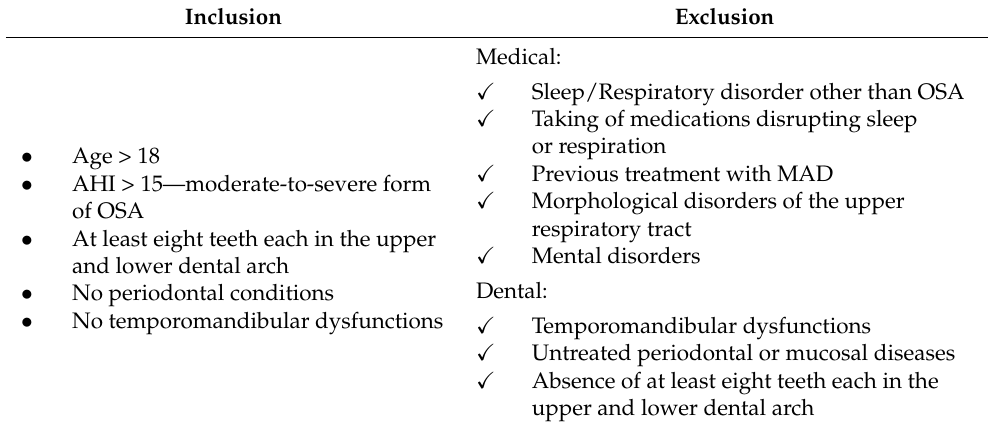
Table 1. Inclusion and exclusion criteria.